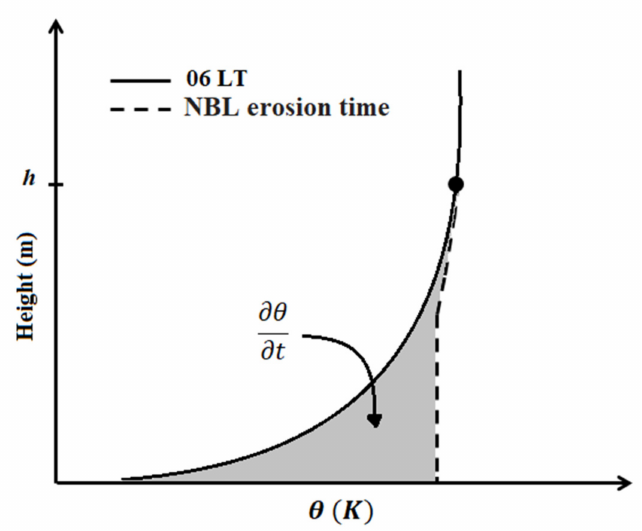
Figure 2. Schematic diagram of the potential temperature profiles at 06 LT (full line) and NBL erosion time (dashed line). The gray area represents the thermal heating of the layer between the two profiles necessary to erode the NBL. (Source: Carneiro et al.